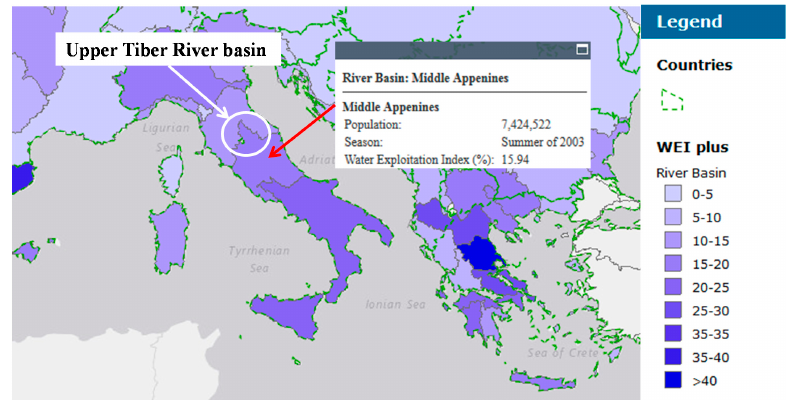
Figure 10. European Environment Agency, WEI + value in summer 2003 for the Middle Appenines District (first version, before October 2018).